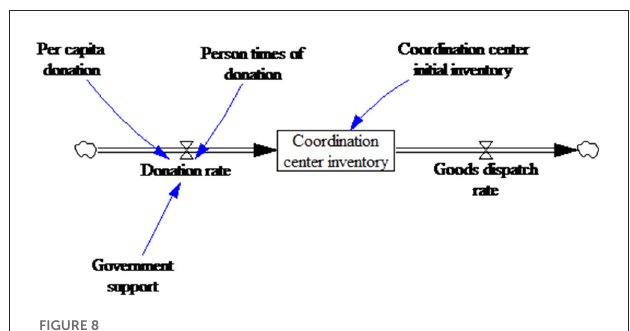
FIGURE8 Donation dimension stock and flow